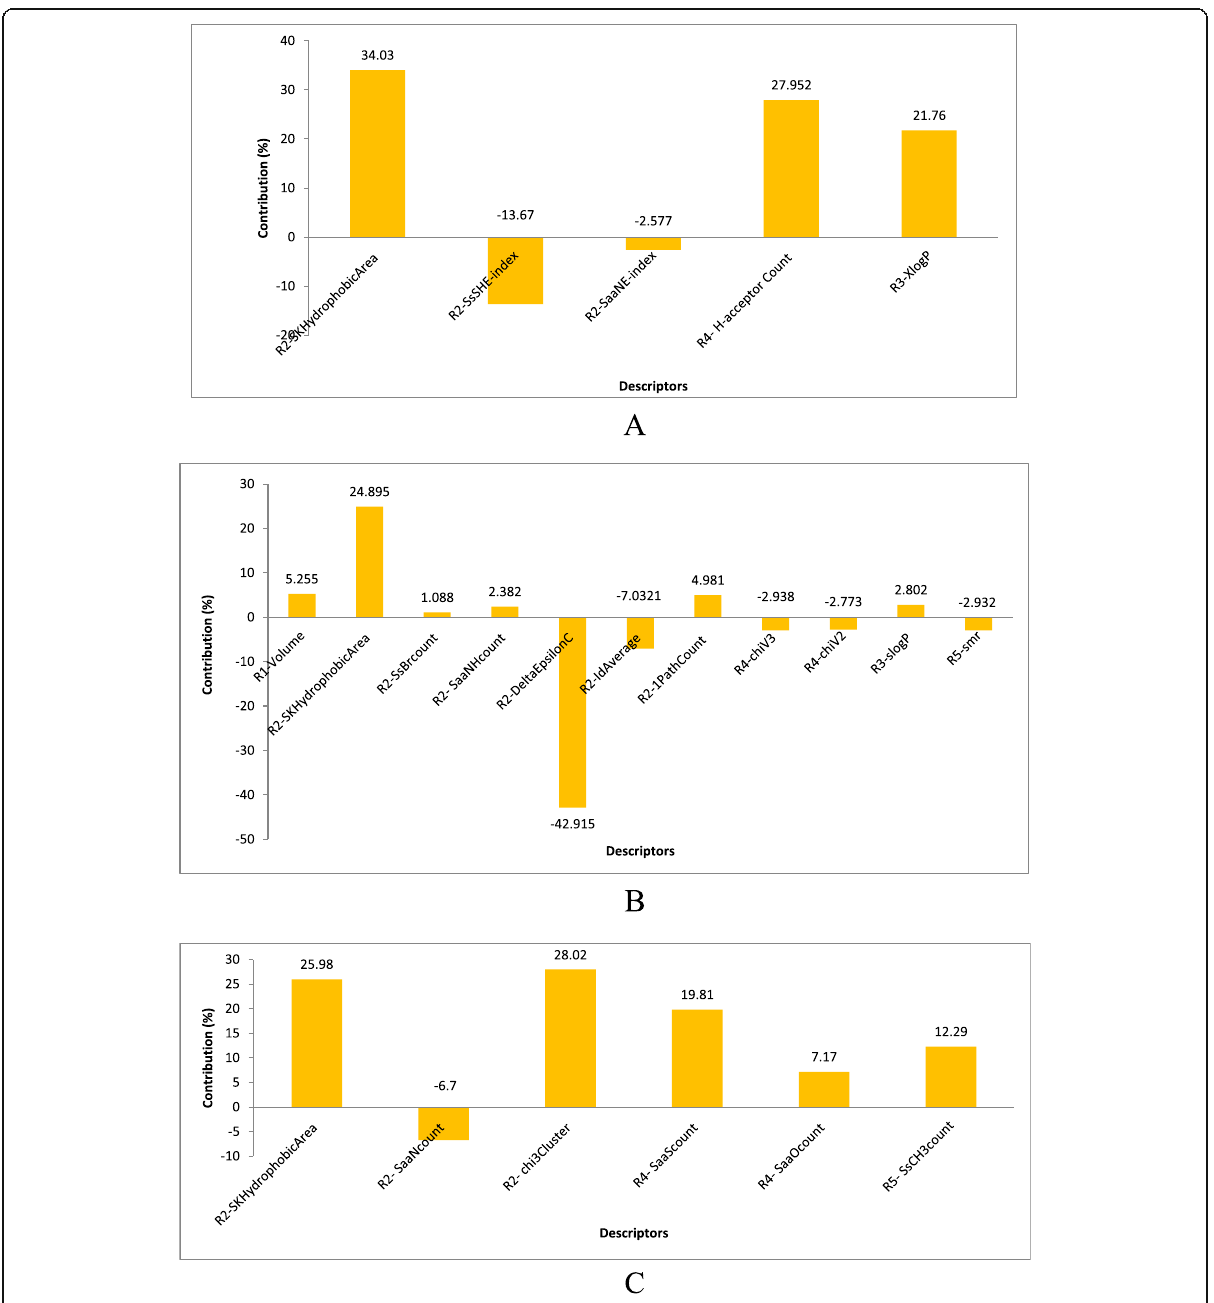
Fig. 6 a – c Contribution plot of descriptors towards pIC 50 for model-I, model-II and